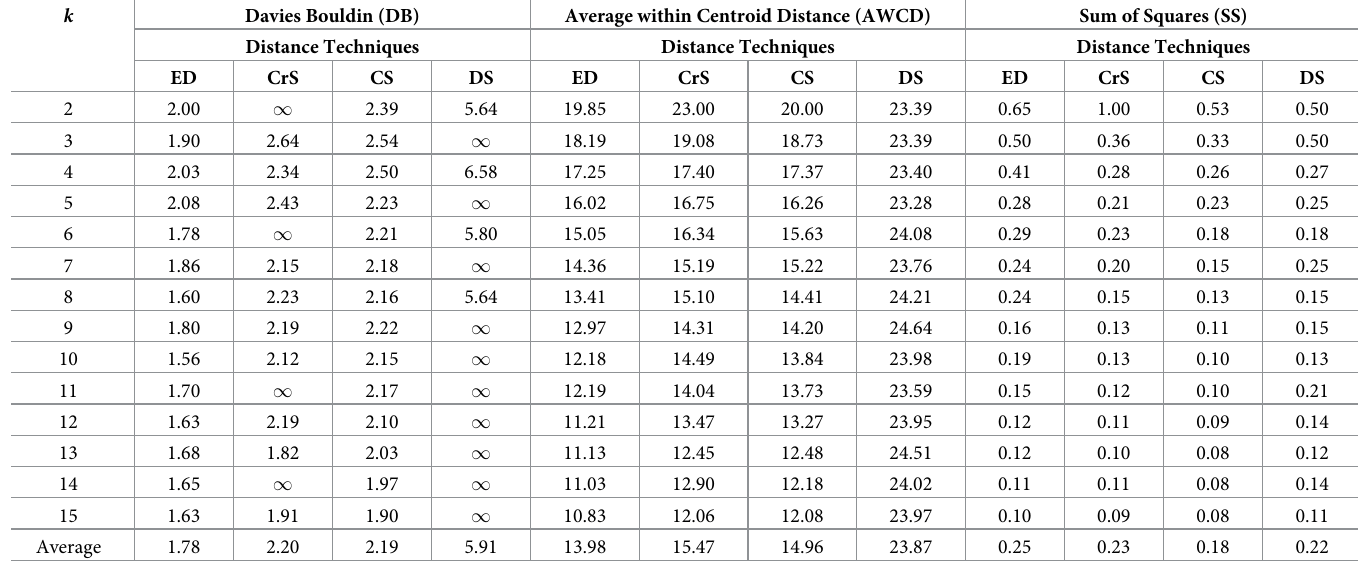
Table 6. Clustering performance based on Davies Bouldin, average within centroid distance and sum of squares for k = 2 to 15 based on Euclidean distance, correla- tion similarity, cosine similarity and dice similarity. k Davies Bouldin (DB)